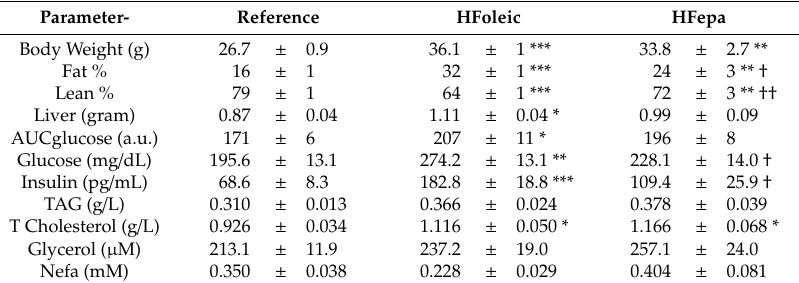
Table 1. Metabolic characteristics of mice after the dietary intervention.